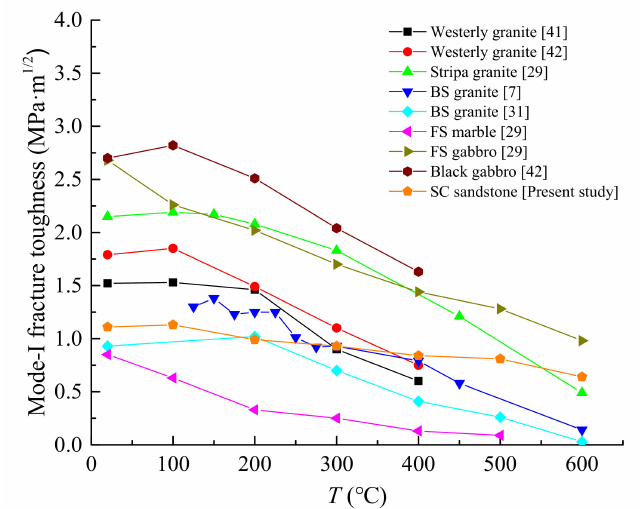
Figure 10. Variation in rock mode-I fracture toughness with temperature.